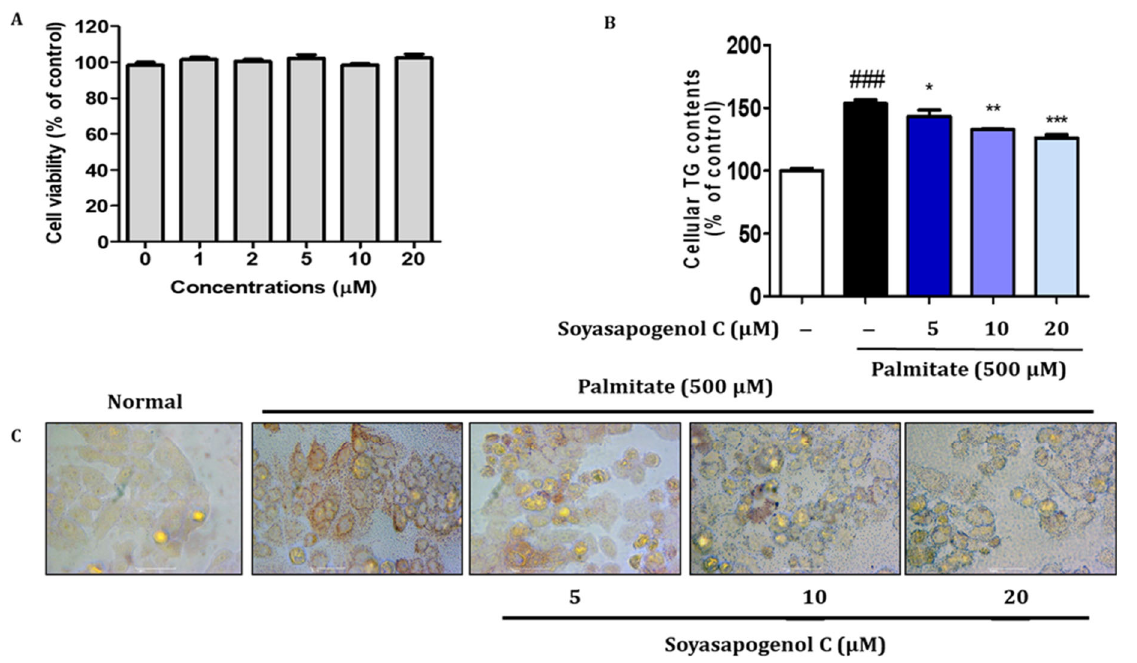
Figure 5. Effects of soyasapogenol C on lipid accumulation in palmitate-treated HepG2 cells. ( A ) HepG2 cells were treated with soyasapogenol C at various concentrations for 24 h, and cell viability was determined via Ez-Cytox assay. HepG2 cells were treated with palmitate for 24 h. ( B ) Measurement of intracellular triglyceride (TG) contents. ( C ) Lipid accumulation was determined via Oil Red O staining. Images of cells were photographed at 200 × magnification. Data are presented as the mean ± SE of three independent experiments. ### p < 0.001 vs. blank, * p < 0.05, ** p < 0.01 and *** p < 0.001 vs. palmitate treated group.